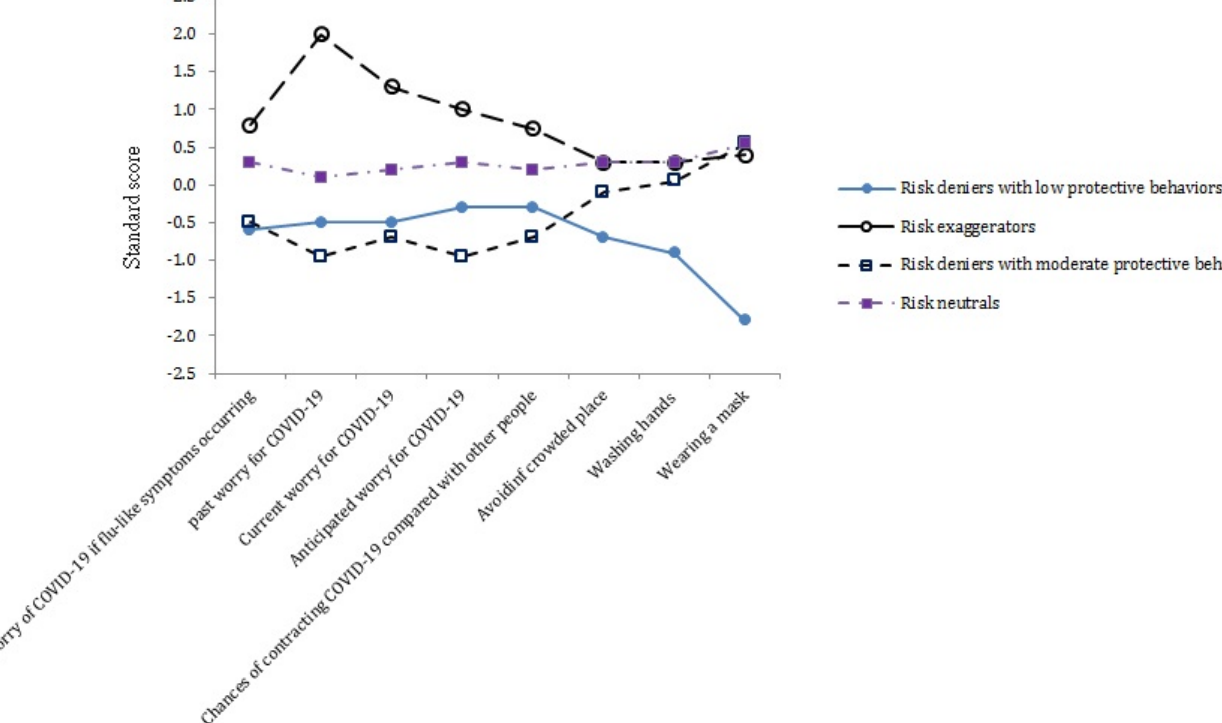
Figure 1. Four classes of participants with various levels of perceived risk of COVID-19 and adoption of preventive be- haviors.